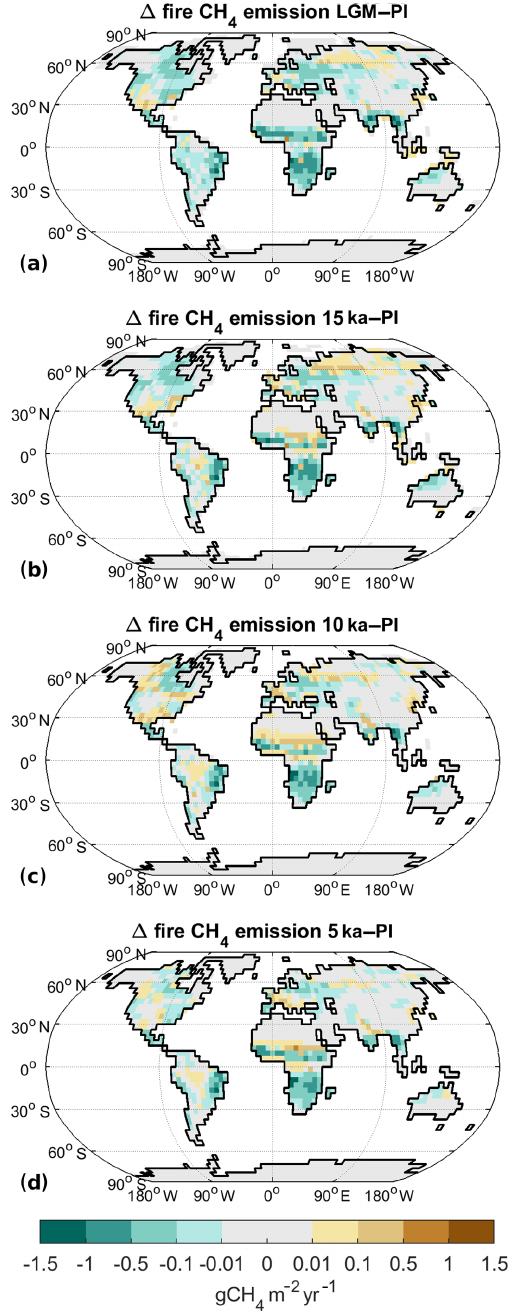
Figure 7. Difference in wildfire methane emissions to preindustrial for (a) LGM, (b) 15ka, (c) 10ka, and (d)